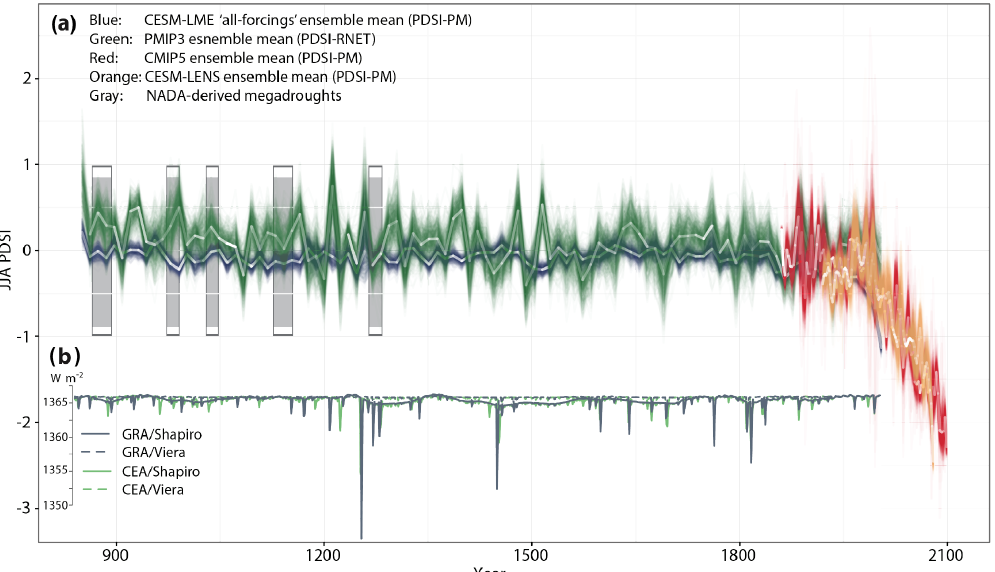
Figure 8. (a) JJA PDSI over the American Southwest for the CESM LME (blues), the CMIP5 historical and projection interval (red), the CESM LENS for the historical and projection interval (orange), and the PMIP3 net radiation PDSI for the last-millennium and projection interval (green). For the CESM LME, the ensemble mean is shown for the all-forcings experiment. For the PMIP3, CMIP5, and LENS, the ensemble mean is shown. For each of the ensemble means, a locally weighted regression is bootstrapped 500 times to highlight the uncertainty in filtering. The median bootstrap value is indicated as a white line in each series, with the color opacity indicating the confidence of the true median value of the regression at that point. Gray bars indicate the five largest megadroughts estimated by the NADA, all of which occurred during the Medieval Climate Anomaly. (b) The combinations of two volcanic (GRA, Gao et al., 2008; CEA, Crowley and Unterman, 2013) and two solar (Viera, Vieira and Solanki, 2010; Shapiro, Shapiro et al., 2011) forcing datasets for the period 1000–2000 CE (from Coats et al.,